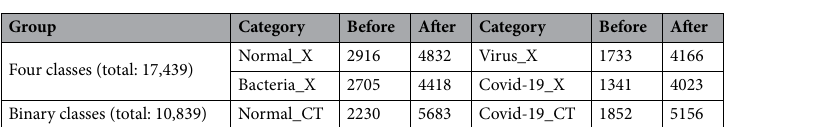
Table 2. The dataset distribution before and after